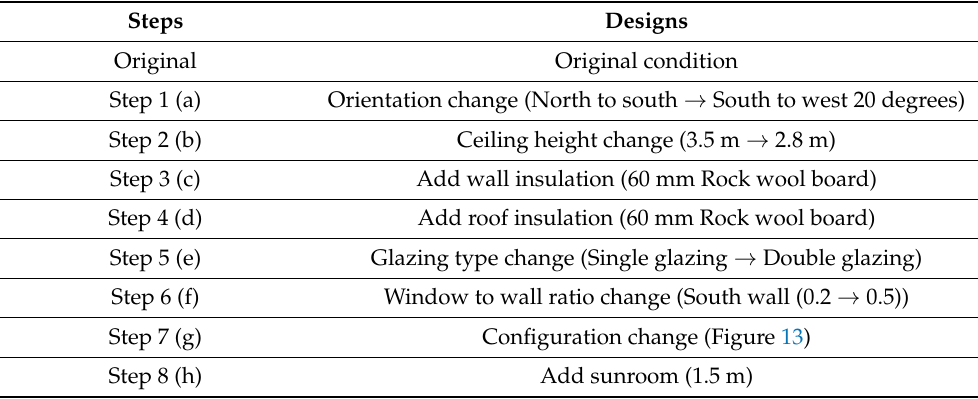
Figure 12. Three-dimensional structure of the typical village house in Xi’an, China. Table 5. Passive design steps are applied to a typical rural house in Xi’an,